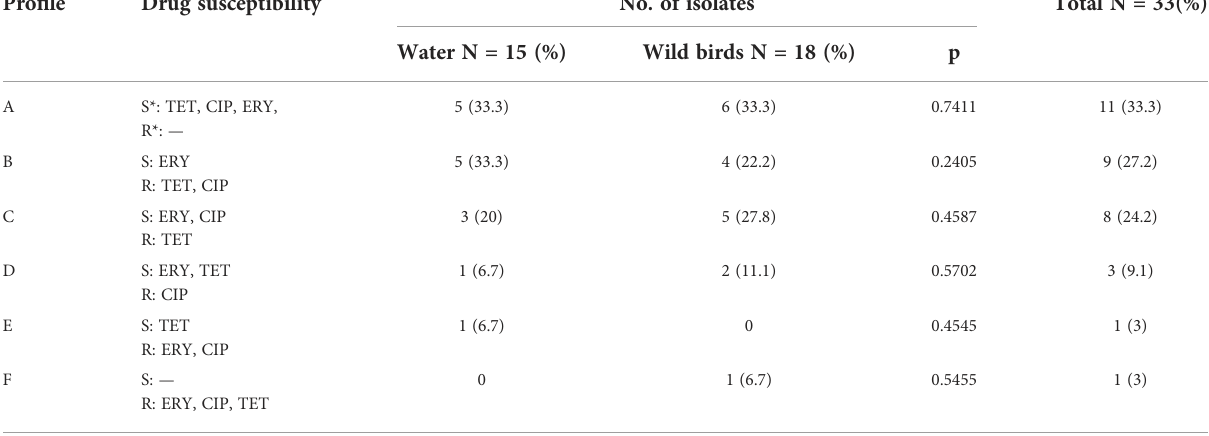
TABLE 4 Drug susceptibility pro fi les of the tested Campylobacter spp. isolated from various sources. Pro fi le